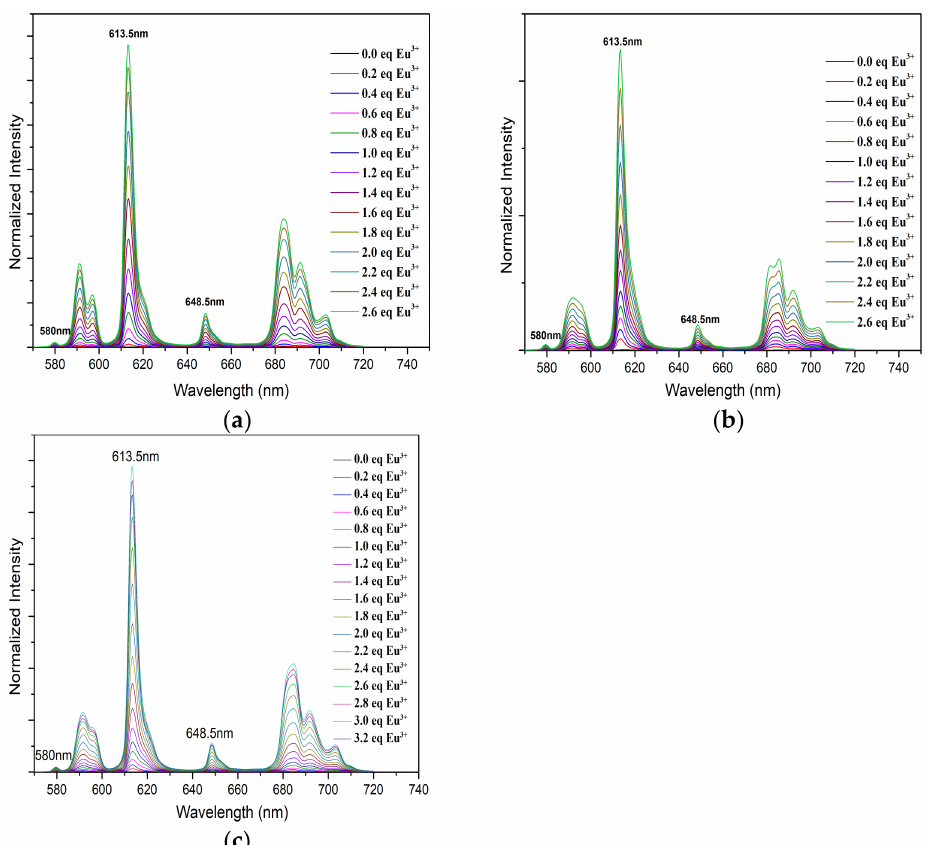
Figure 6. Normalized fluorescence emission spectra of Eu(III) in methanol with increasing BTPhen concentration. (Eu(lll))ini = 1 × 10 − 5 mol/L; V ini = 2 mL; (L 1 , L 2 , L 4 ) = 1 × 10 − 3 mol/L; 4 µ L of ligand solution was added at one time. ( a ) Description of emission spectra of Eu (lll) with L 1 ; ( b ) Description of emission spectra of Eu(lll) with L 2 ; ( c ) Description of emission spectra of Eu(lll) with L 4